Question: Write a caption explaining this figure to a reader.
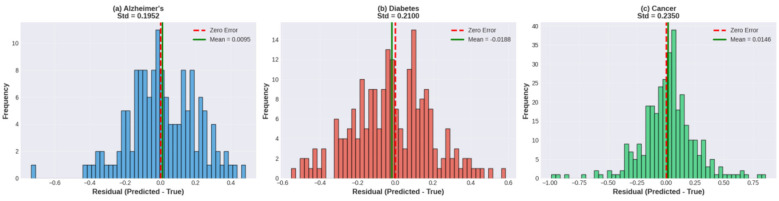
Answer: Residual distribution analysis: (a) Alzheimer's, (b) Diabetes, and (c) Cancer.